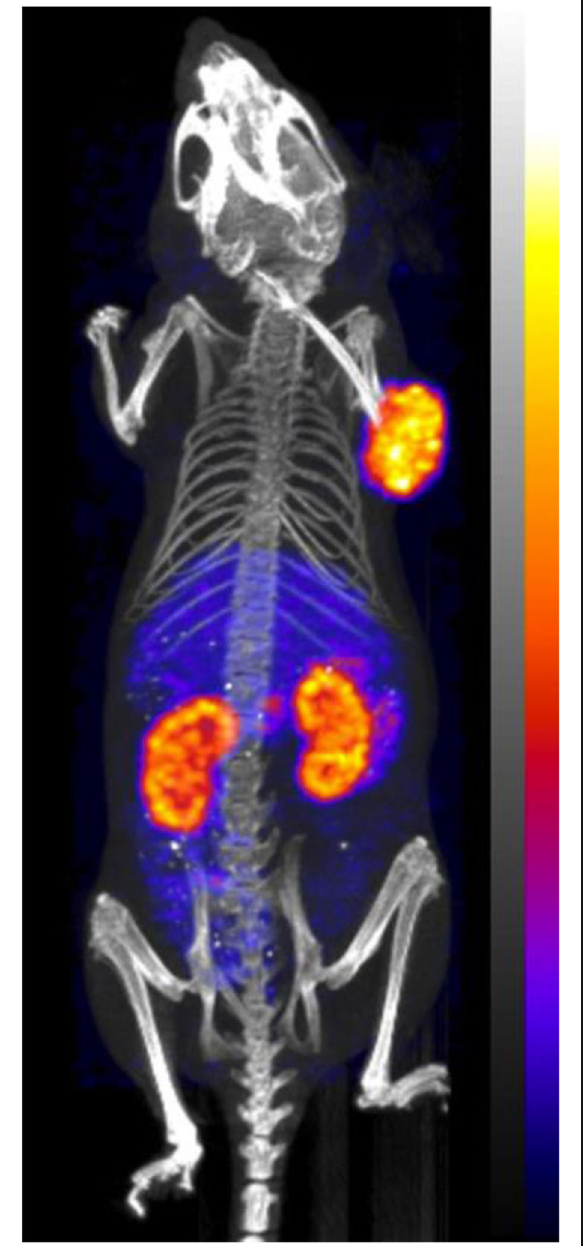
Fig. 5 SPECT/CT imaging of 99m Tc-SS-04 on HEK-rsst2-xenograft-bearing mouse. Maximum intensity projection (MIP) of the nanoSPECT/CT image acquired 4 h after injection of 15 MBq (150 pmol peptide) 99m Tc-SS-04 in a HEK-rsst2-xenograft-bearing mouse. The colour bar corresponds to 0 – 90%IA/g